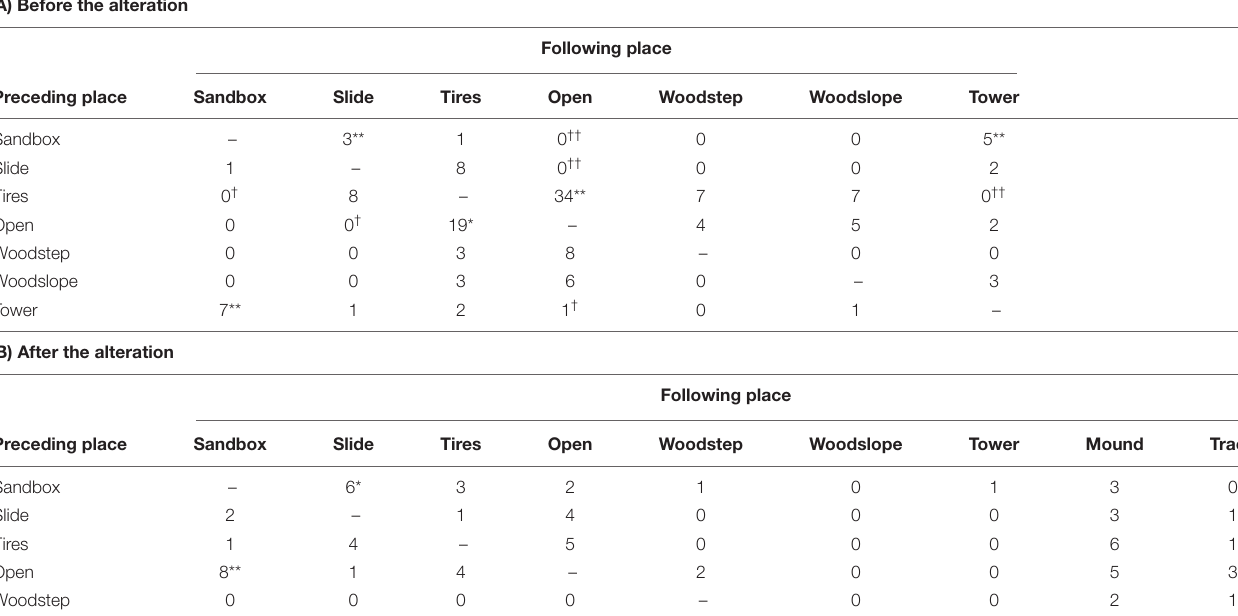
TABLE 5 | Frequencies of sequential transition between consecutive places in playground before and after the alteration. (A) Before the